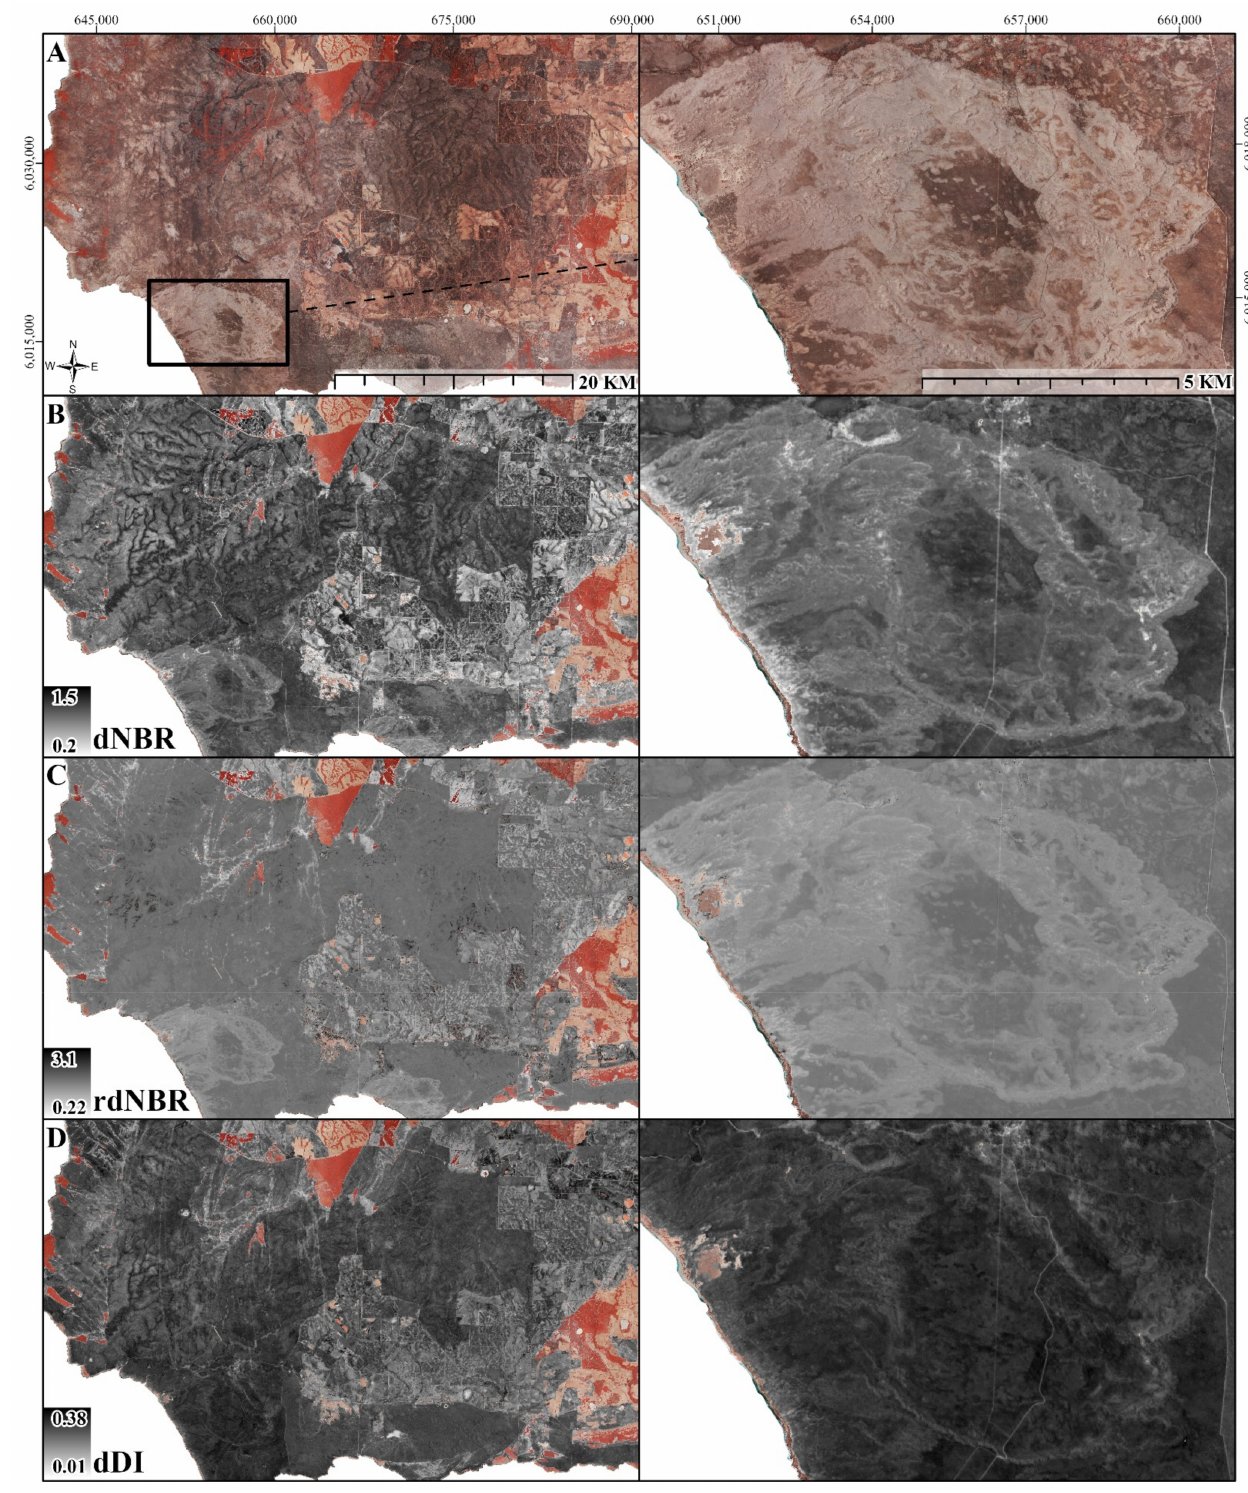
Figure 7. Top row of figure ( A ) is colour IR imagery from January 2020 with inset map showing extent of burned dune soils (CDC) and the border of the darker soils from the low-land Pleistocene formation (ROR). Rows 2–4: Comparison of fire severity values overlain on colour infrared aerial imagery from dNBR ( B ), rdNBR ( C ) and dDI ( D ). Darker values show higher relative index values and severity. Enlargements on the right-hand side showing the effect of soil brightness on dNBR and rdNBR values. Imagery is masked according to a dNBR threshold (>0.2) with all indices displaying data 3 STDs from mean with 1.5